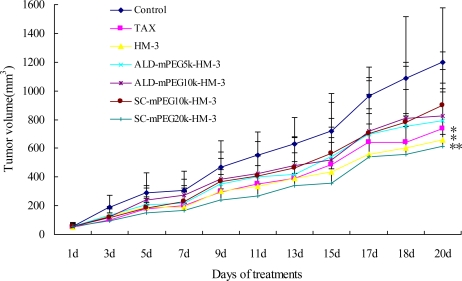
Therapeutic effects of peptides on the growth of tumors in BALB/c nude mice. Each point represents mean ±SD of each group (mean ± SD, n = 6, *P < 0.05; **P < 0.01 versus control). Control, once a day; The positive control drug Taxol at the dose of 10 mg/kg twice a week; HM-3 at the dose of 3 mg/kg twice a day; ALD-mPEG5k-HM-3 at the dose of 11.4 mg/kg once a day; ALD-mPEG10k-HM-3 at the dose of 19.9 mg/kg once every 2 day; SC-mPEG10k-HM-3 at the dose of 19.9 mg/kg once every 2 days; SC-mPEG20k-HM-3 at the dose of 36.7 mg/kg once every 2 day.